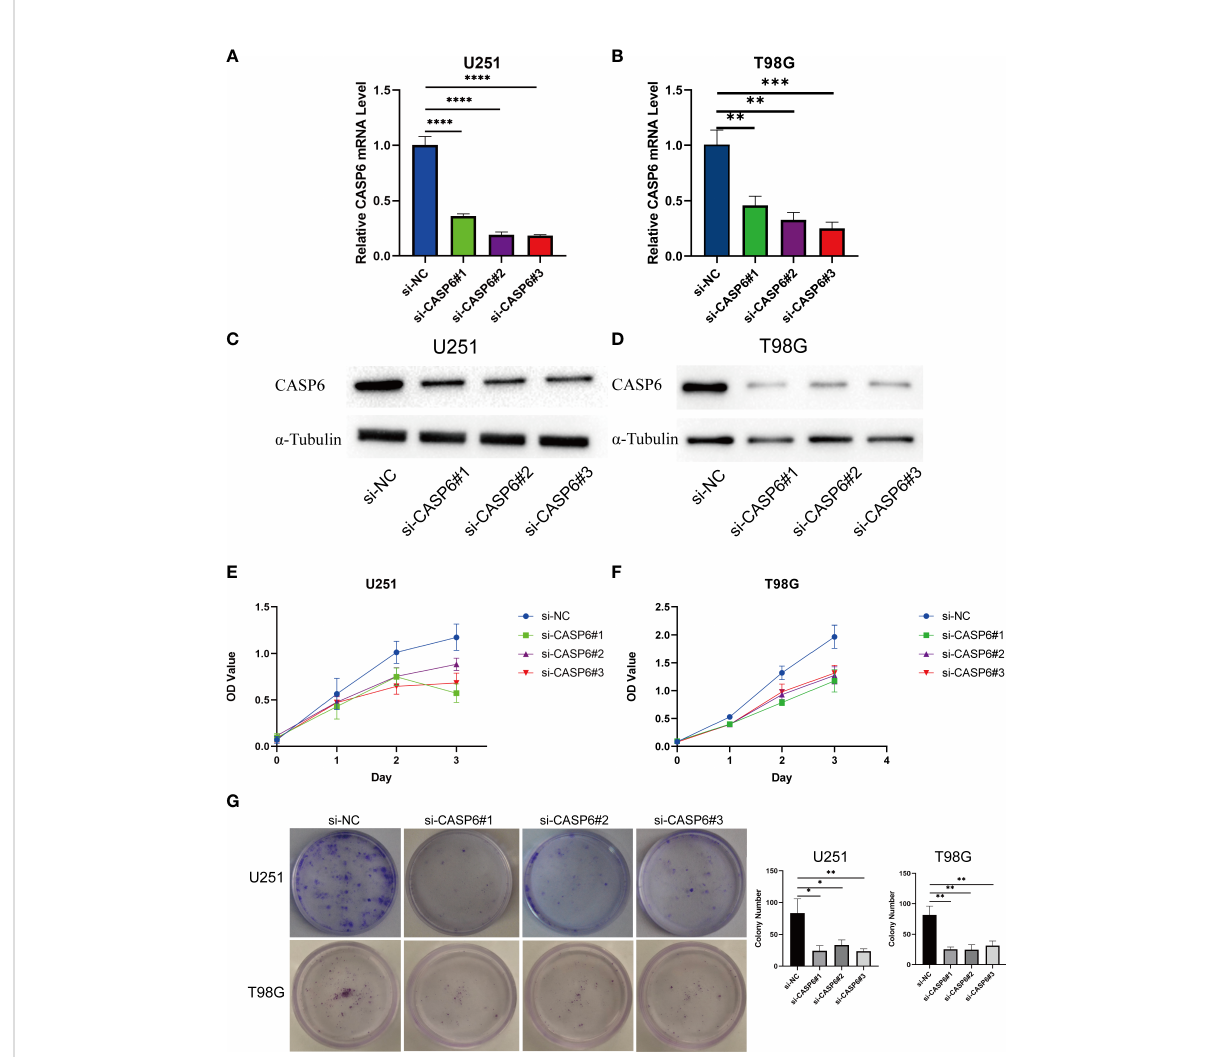
FIGURE 8 Results of loss of function experiments in U251 and T98G glioma cell lines. (A, B) The CASP6 knockdown ef fi ciency of different siRNAs in U251 and T98G cells. (C, D) Identi fi cation of CASP6 knockdown ef fi ciency by western blotting. (E, F) CCK-8 assays of U251 and T98G glioma cell lines knocked down for CASP6 . (G) Colony formation assays of U251 and T98G glioma cell lines knocked down for CASP6 . *P < 0.05, **P < 0.01, ***P < 0.001, ****P <